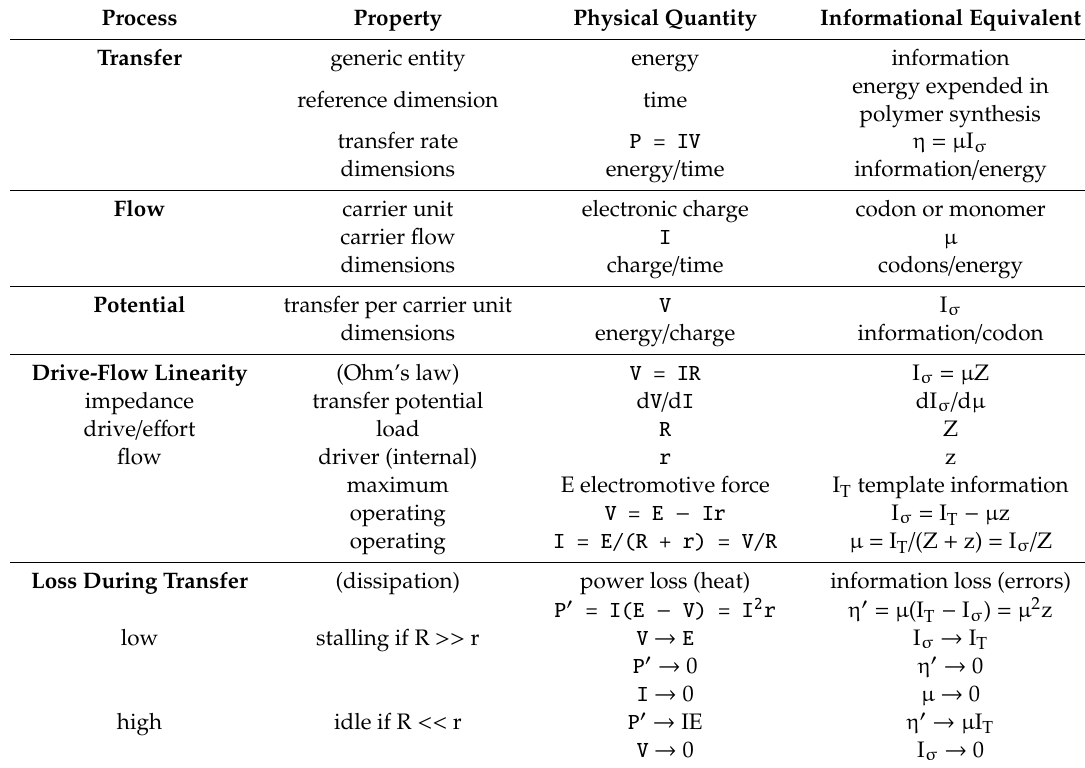
Table 1. List of